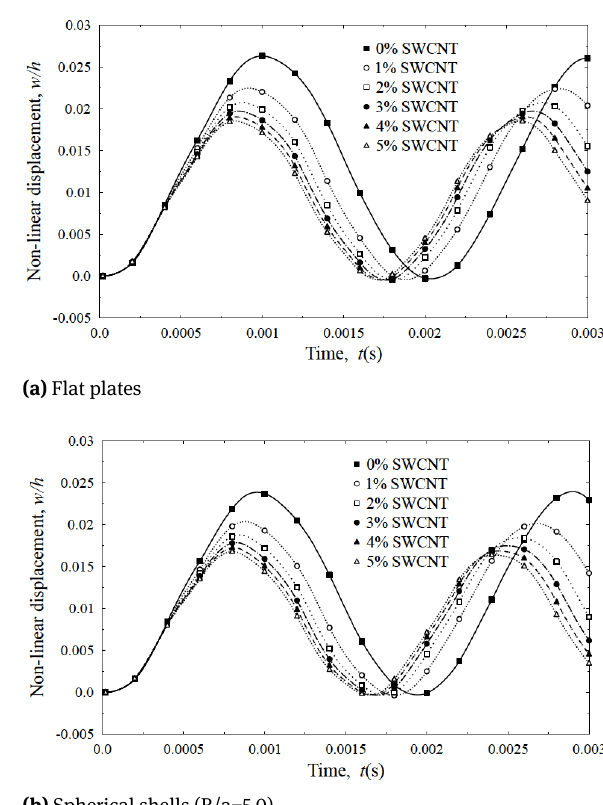
Figure 5: Nonlinear transient displacements ( w / h ) of SWCNT rein- forced composite flat plates and spherical shells ( q = 1.0 MPa, [0/90] s , V f = 0.8 , no